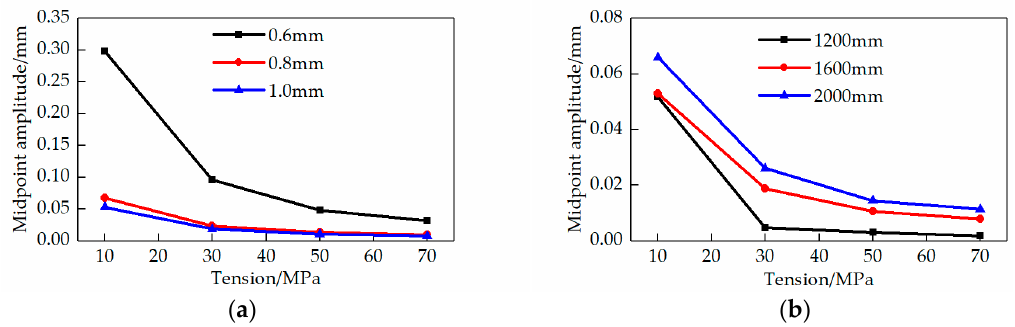
Figure 10. The midpoint amplitude changes of different strips with tensions. ( a ) Different thicknesses; ( b ) different widths.